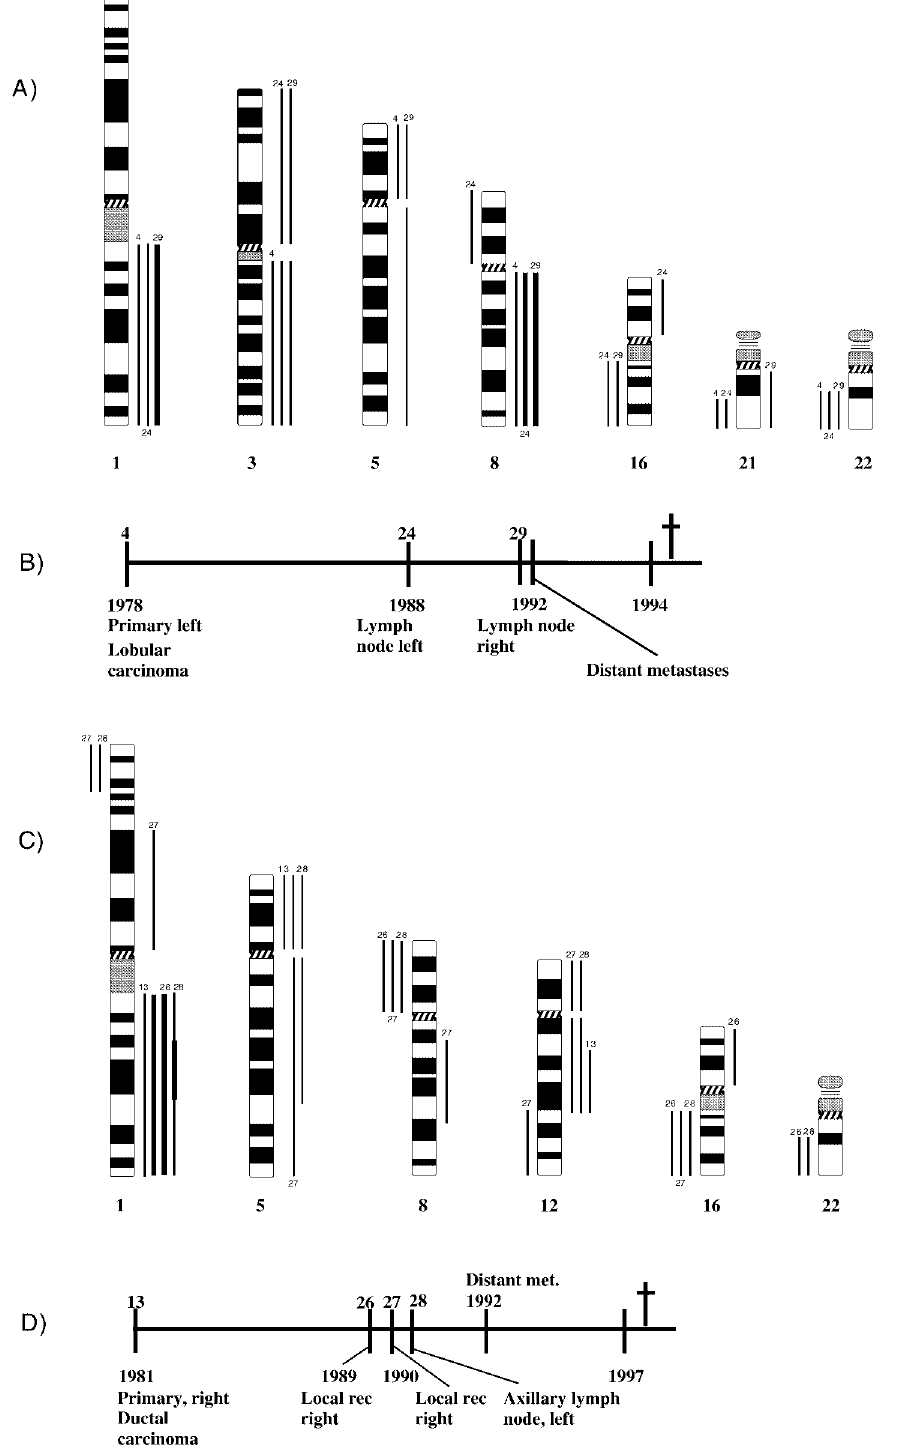
Fig. 6. Two representative cases of breast carcinoma with primary tumors 4 and 13 (indicated in (B) and (D)) and their recurrencies. In (A) and (C) specific and recurrent chromosomal gains and losses are shown for each tumor as indicated by numbers on top of the